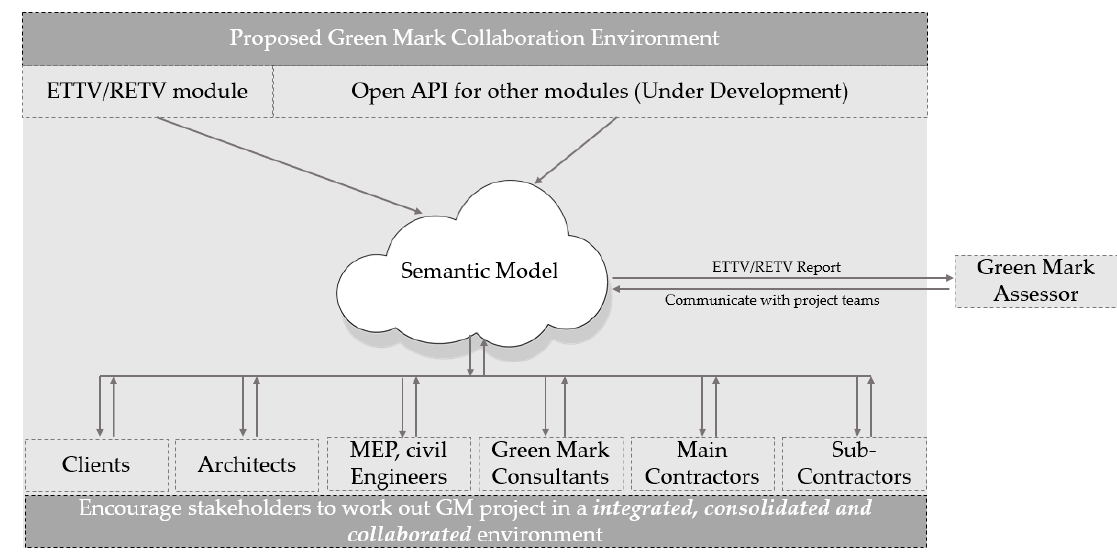
Figure 5. Framework of a collaborative working environment.